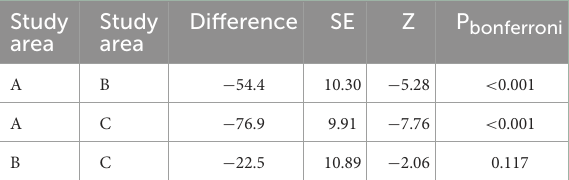
TABLE 2 Post-hoc comparison tests for the generalized linear models regarding differences in return time between buffers. Study area